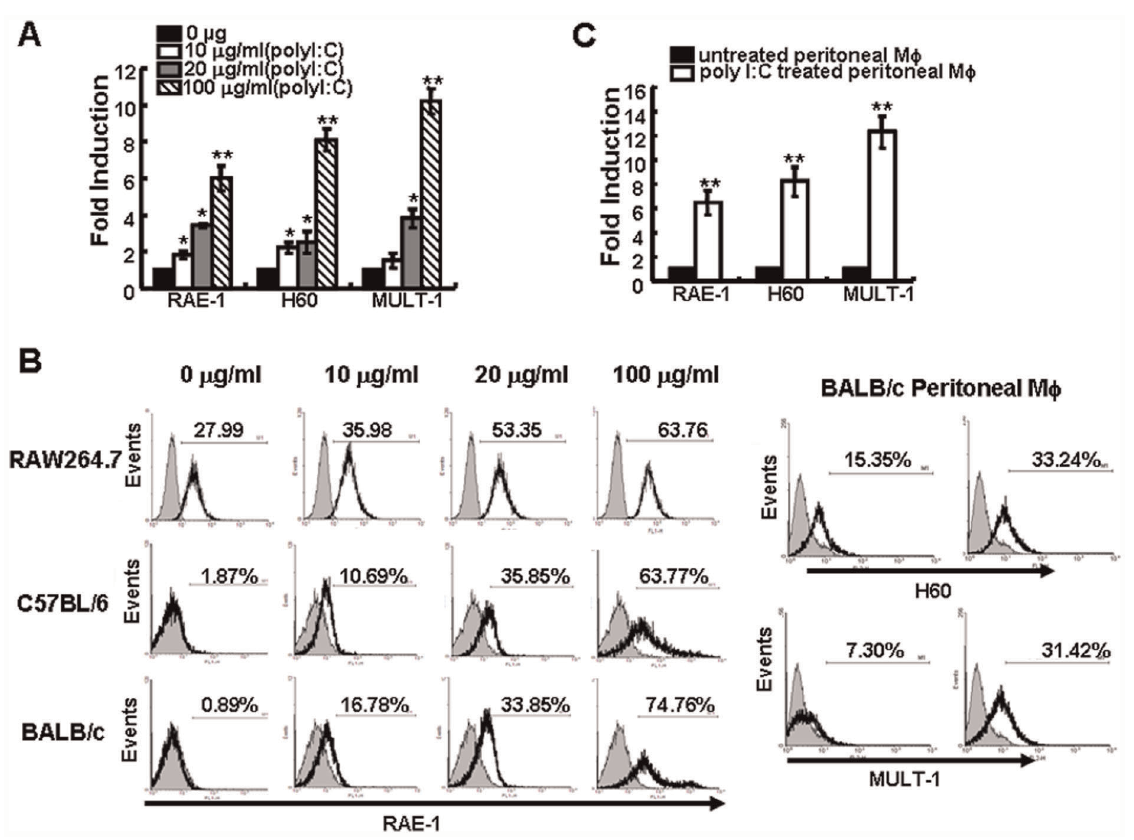
Figure 3. Up-regulation of NKG2D ligands on poly I:C-treated murine macrophages. Murine macrophage RAW264.7 cells were cultured for 24 h with 0, 10, 20 or 100 m g/ml poly I:C and analyzed by RT-PCR or FACS. The data are expressed as fold induction of RAE-1, H60 or MULT-1 mRNA (A) or the percentage of positive RAE-1 staining using monoclonal pan-RAE-1 antibodies (B). Resident peritoneal macrophages from BALB/c or C57BL/ 6 mice were treated with either 0 or 100 m g/ml poly I:C for 24 h and NKG2D ligand transcripts and surface expression were analyzed by real-time PCR (C) or FACS (B). Data shown are expressed as the mean 6 SD from at least three separate experiments. *p , 0.05, **p , 0.01 compared with untreated cells.